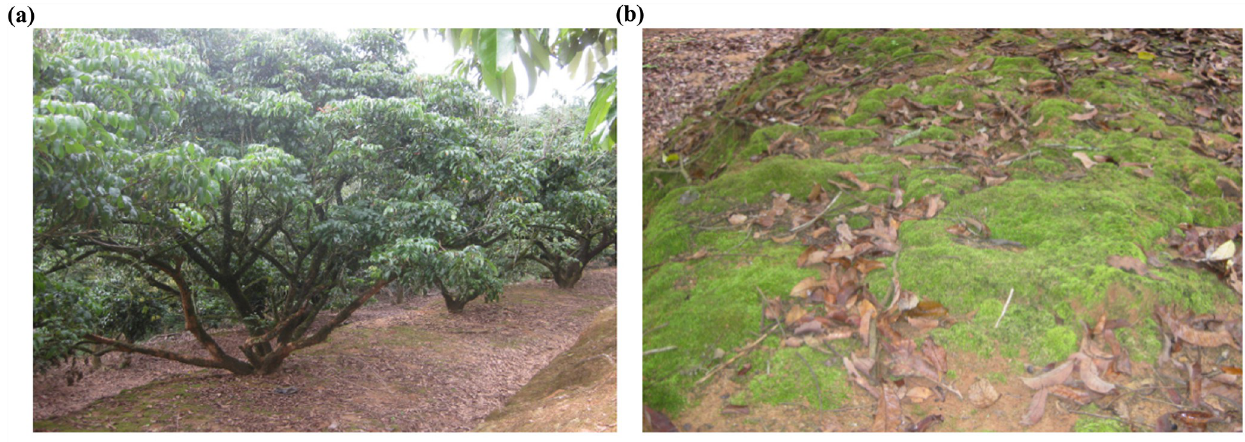
Fig 1. Moss carpets forming on the soil surface in litchi